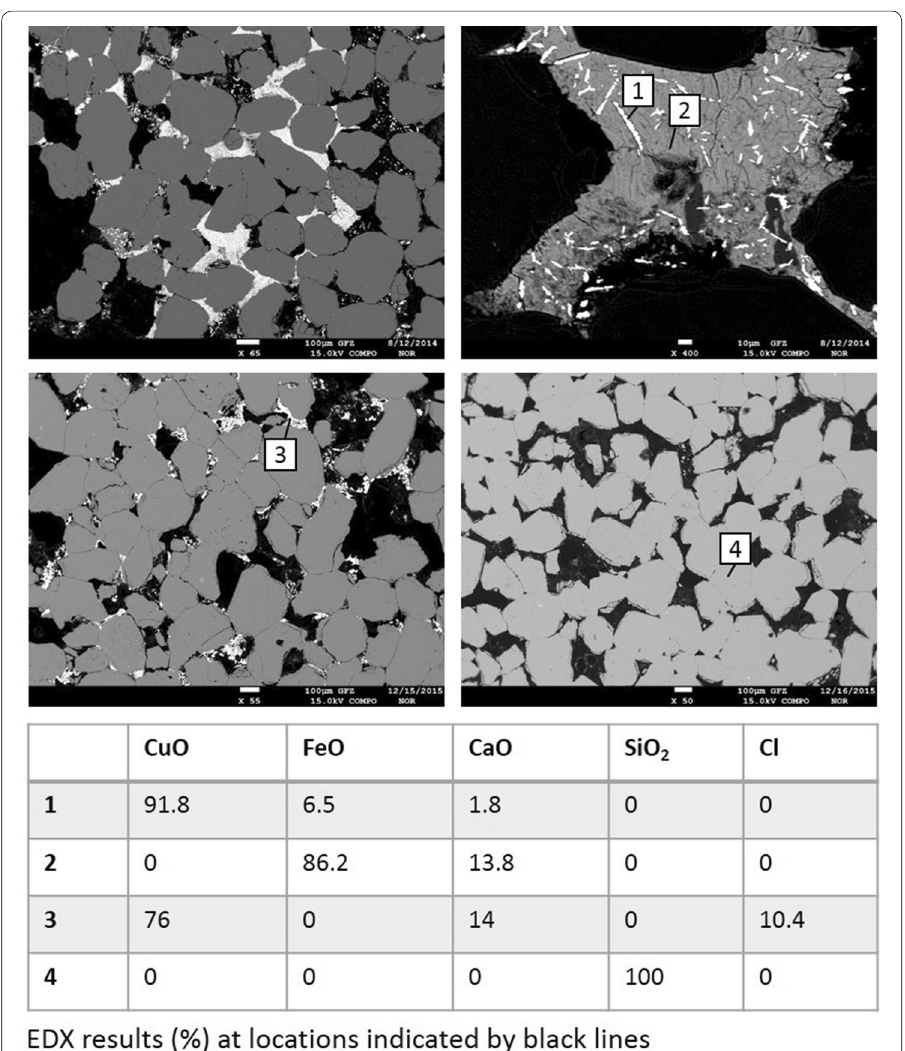
Fig. 5 Electron microprobe pictures of rock thin sections after the experiments: Roundish grey areas represent quartz particles of the sandstone; black areas indicate pore space; white areas indicate high-density. Top left oxic-treated sandstone sample (O). Top right enlargement of one pore of the top–left picture filled with Fe-hydroxides ( grey areas ) and pure Cu ( white needle-shaped areas ). Bottom left sample from experiment C; Bottom right sample from experiment E (use of stainless steel) with intact pore space. The corresponding table shows semi-quantitative EDX results of elemental composition of four different locations as indicated by